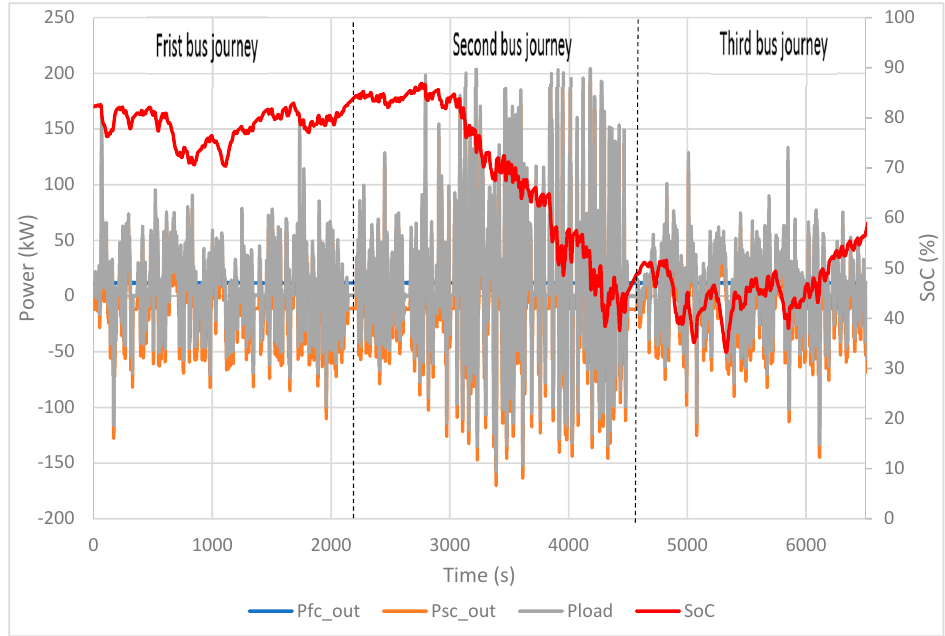
Figure 11. Power balancing and SoC change of 135-minute bus profile.